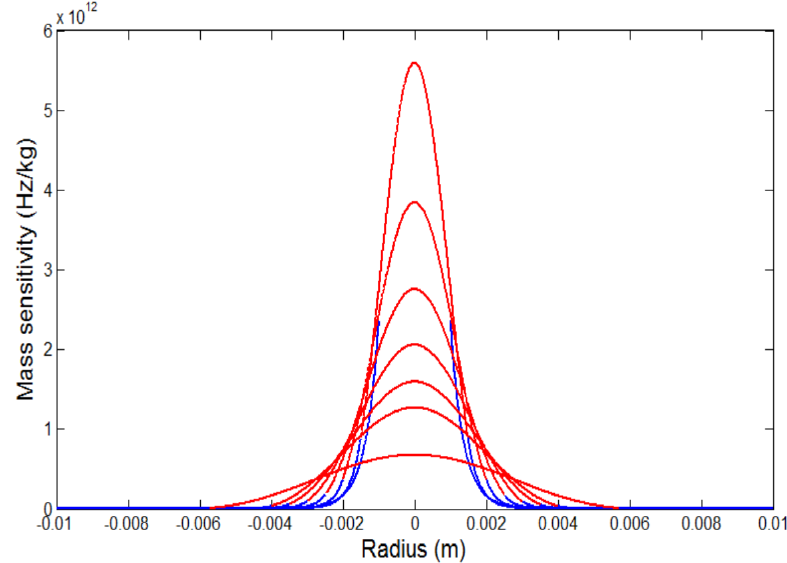
Figure 2. Mass-sensitivity distribution profiles for AT-cut 10 MHz QCMs with different-sized electrodes. From top to bottom in the figure the radiuses of the electrode are, in order, 1.5, 2, 2.5, 3, 3.5, 4, and 5.7 mm. Red line represents the electrode region and blue line represents the non-electrode region.